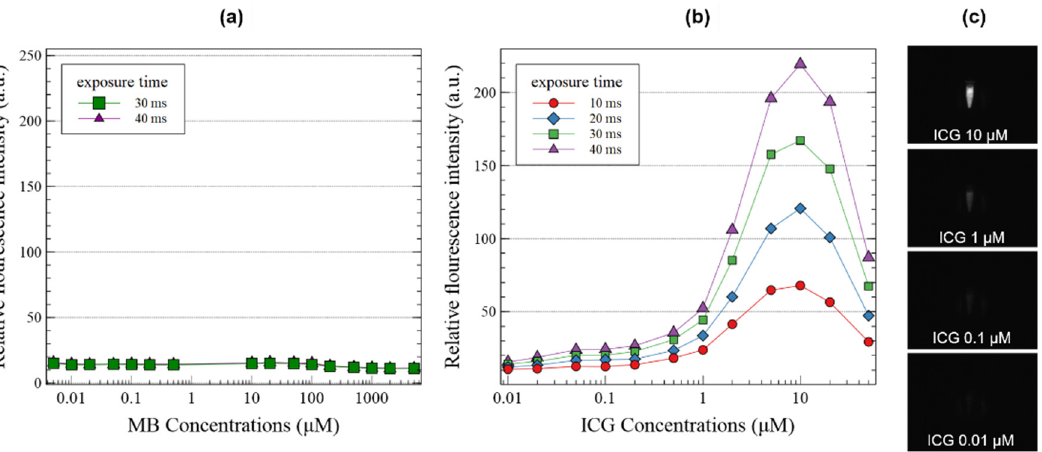
Figure 6. ( a ) Crosstalk effect of the methylene blue (MB) under 785 nm laser diode (LD) and ( b ) indocyanine green (ICG) under 680 nm LD depending on the concentrations of the two fluorescent contrast agents and exposure time of the camera ( c ) NIR images of ICG under 680 nm LD.